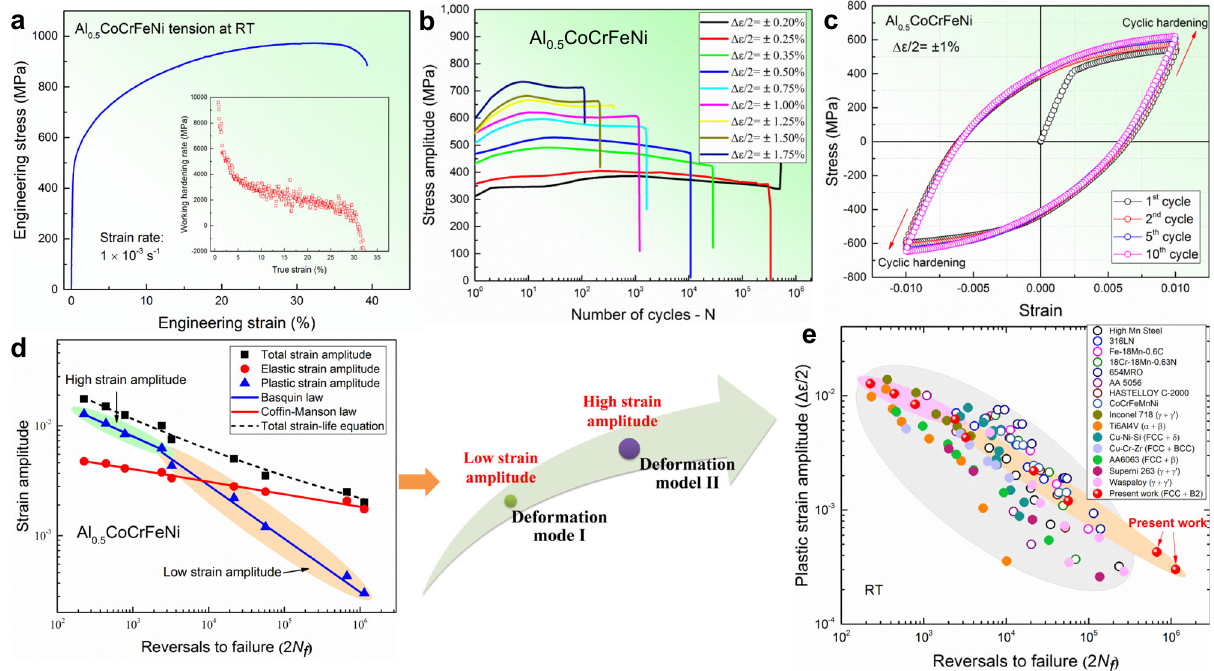
Fig. 2 Tensile and LCF results of the Al 0.5 CoCrFeNi alloy. a Uniaxial tensile curve of the Al 0.5 CoCrFeNi alloy at RT (an inset fi gure shows its working- hardening rate versus true strain). b Cyclic stress response (CSR) curves of the Al 0.5 CoCrFeNi HEA at different strain amplitudes. c Hysteresis loops of the Al 0.5 CoCrFeNi HEA at selected numbers of cycles fatigued at the strain amplitude of ±1%. d Total strain amplitude, elastic-strain amplitude, and plastic- strain amplitude versus the number of reversals to failure (2 N f ), displaying the presence of a bilinear Cof fi n – Manson relationship that signi fi es a variation of the cyclic-deformation modes (cartoon fi gure). e The comparison of Cof fi n – Manson fatigue data for the present alloy and other conventional alloys, showing the superior LCF properties of the studied HEA at low strain amplitudes, relative to other conventional alloys (open-circle and solid-circle symbols represent single-phase and precipitation-strengthened alloys, respectively) 24 – 37